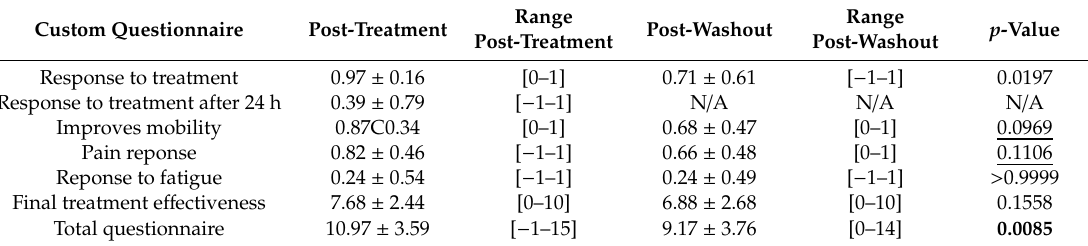
Table 4. Patient response to therapy assessed by score-di ff erences in our